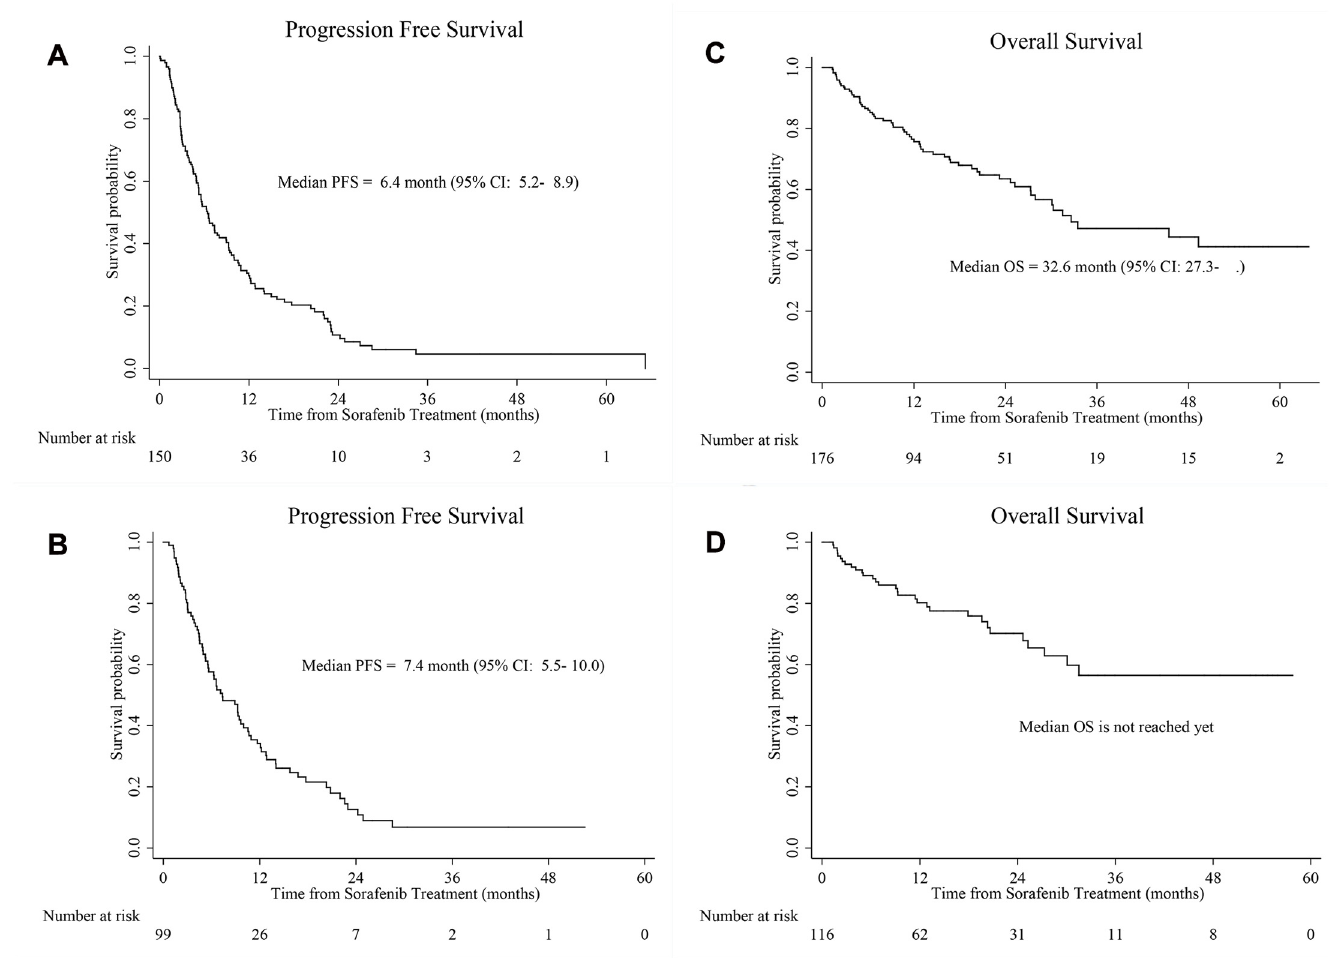
Fig 1. Progression-free (PFS) and overall survivals (OS) for (A, C) all 177 patients and (B, D) 116 patients treated with first-line sorafenib, respectively. CI, confidence interval.